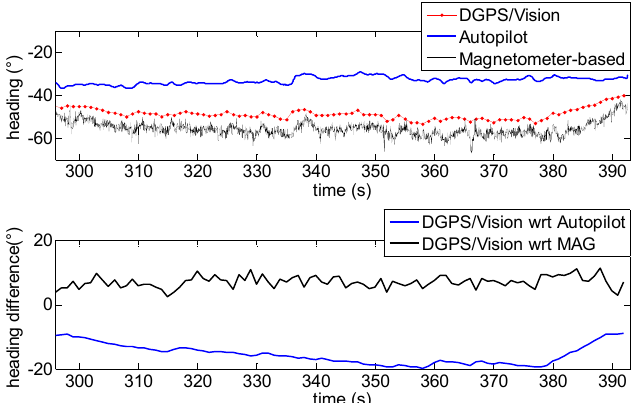
Figure 17. Heading angle as a function of time ( Top ), differences of DGPS/Vision with respect to autopilot and magnetometers ( Bottom ) during the second flight segment (Test 1).